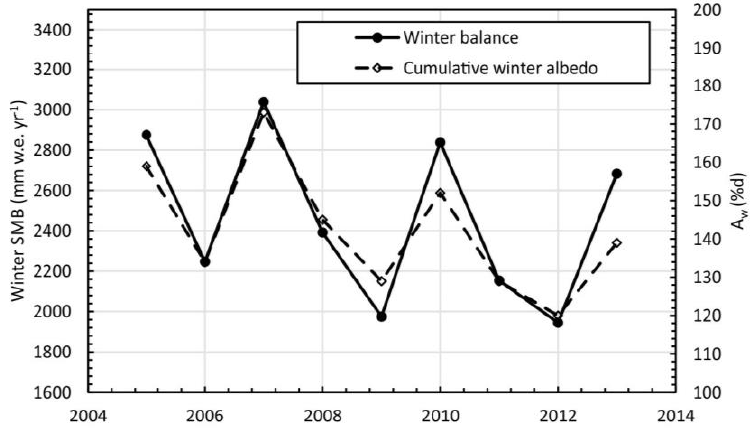
Figure 7. Temporal variations of winter mass balance and cumulative winter albedo for Brewster Glacier.